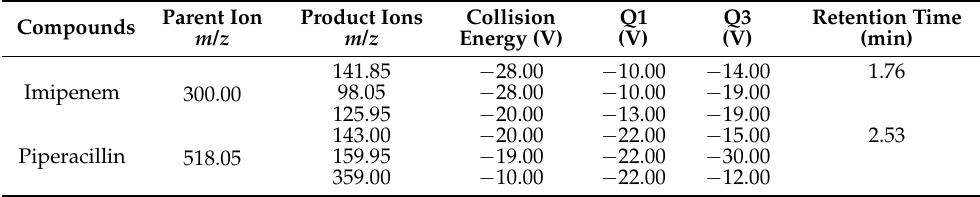
Table 2. LC-MS/MS parameters for imipenem and